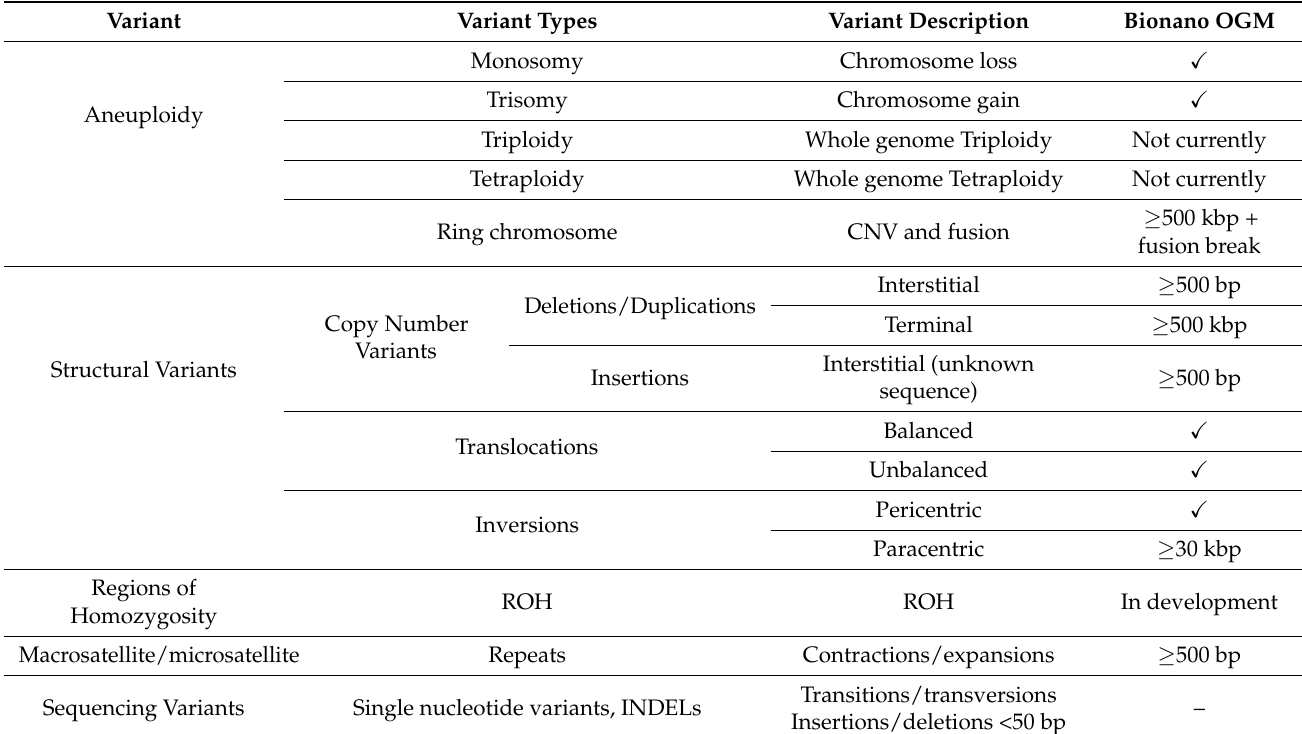
Table 1. Specification of optical genome mapping for the detection of different variant